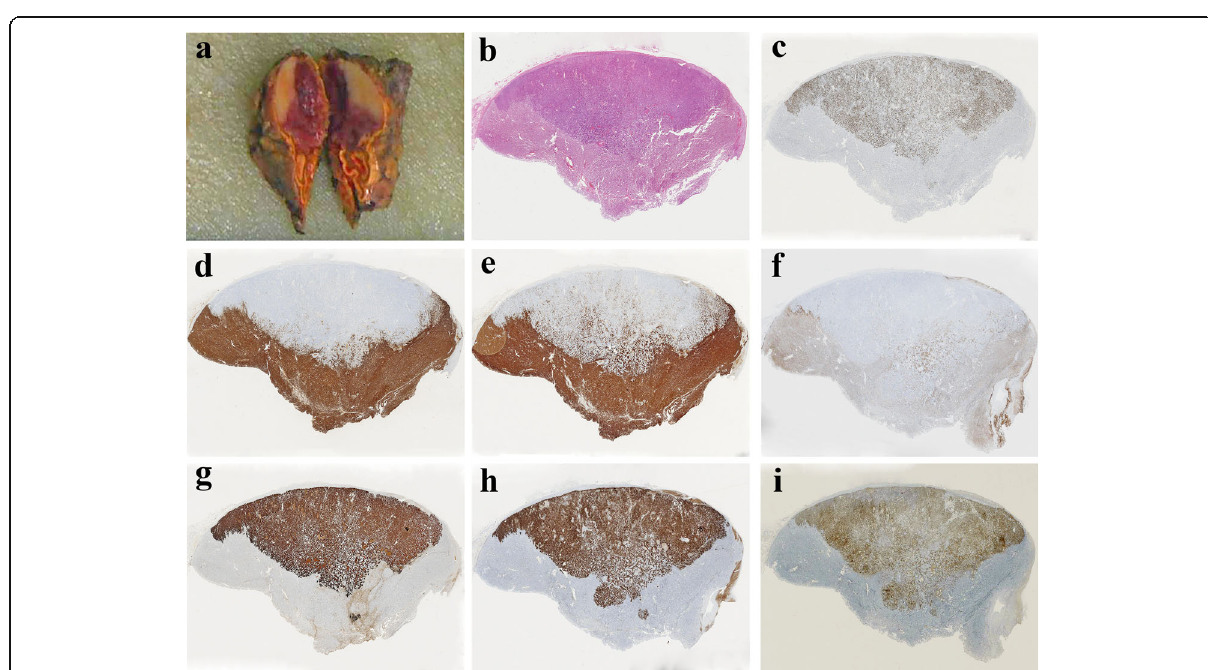
Fig. 3 The cut surface of the tumor is divided into two parts: whitish and pinkish-grey ( a ). Histological staining with hematoxylin and eosin shows that the cells of both parts are similar ( b ). The proliferative index (Ki67) of metastatic breast cancer is significantly higher than that of pheochromocytoma ( c ). Immunohistochemistry shows that pheochromocytoma cells are strongly positive for CgA, SYN and CD56 ( d , e and f ), and metastatic breast carcinoma cells are strongly positive for CK, HER-2 and membrane positive for E-cadherin ( g , h and i